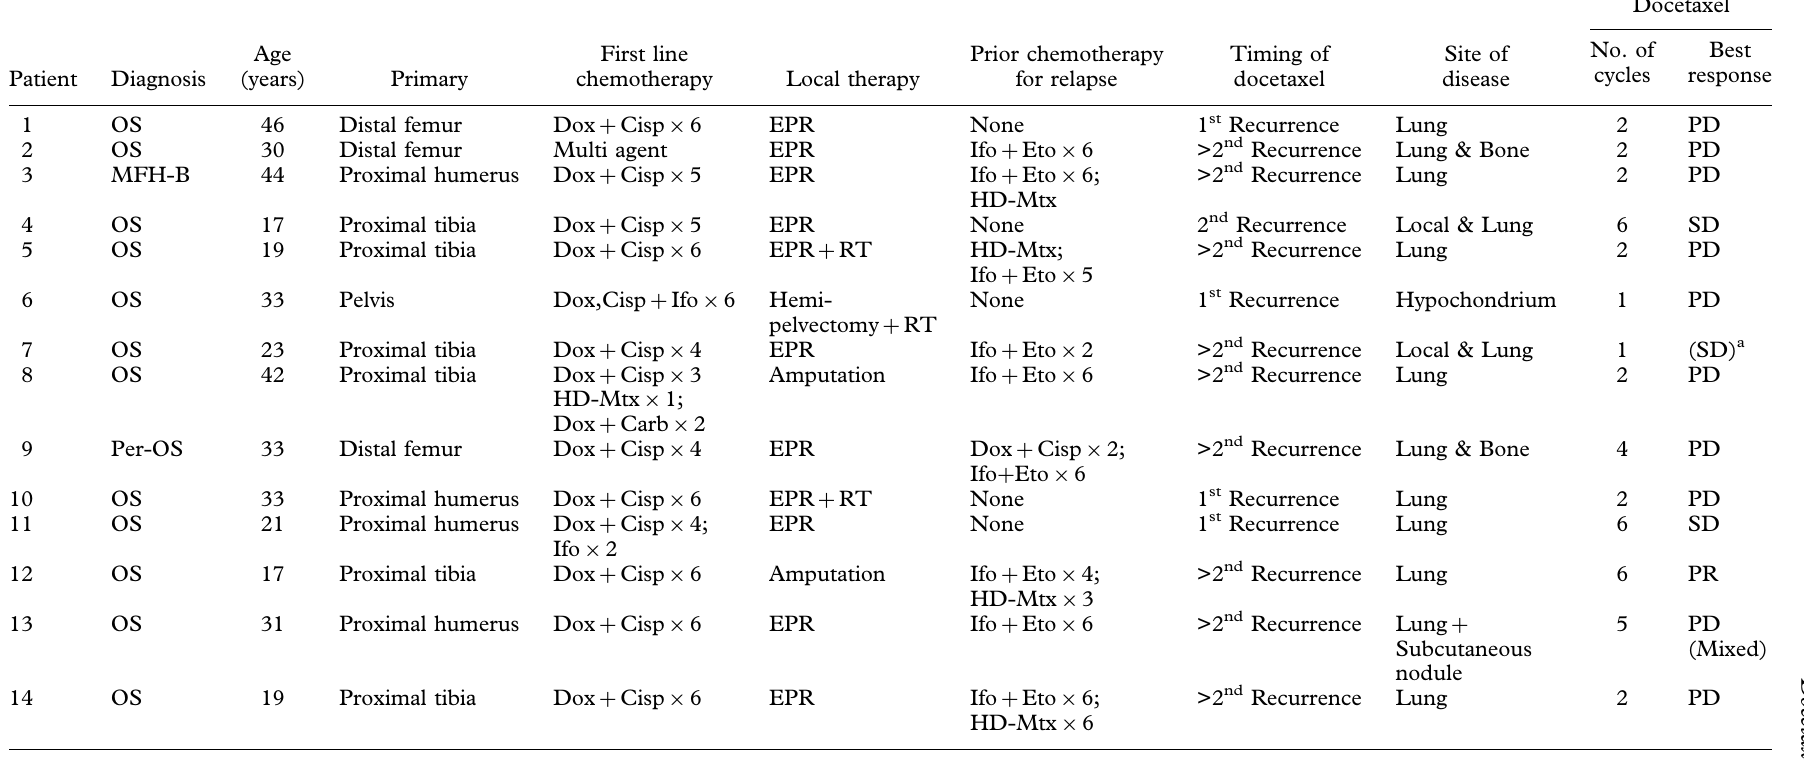
Table 1. Patient characteristics and